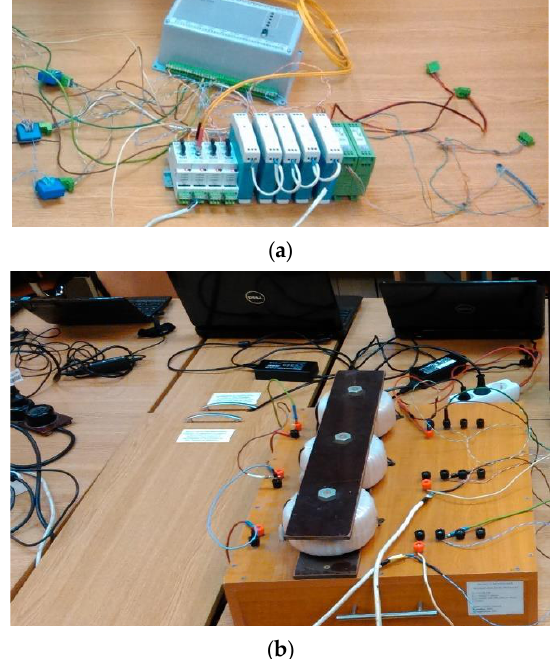
Figure 1. The set-up for measurement: ( a ) left — DAS with sensors for current; middle — DAS sup- plying sources; right — connectors toward laptop(s) (right) [22]; ( b ) Partial representation of the test setup with single/three-phase consumers connected to the secondary winding of transformers spe- cially manufactured for these applications in toroidal forms.